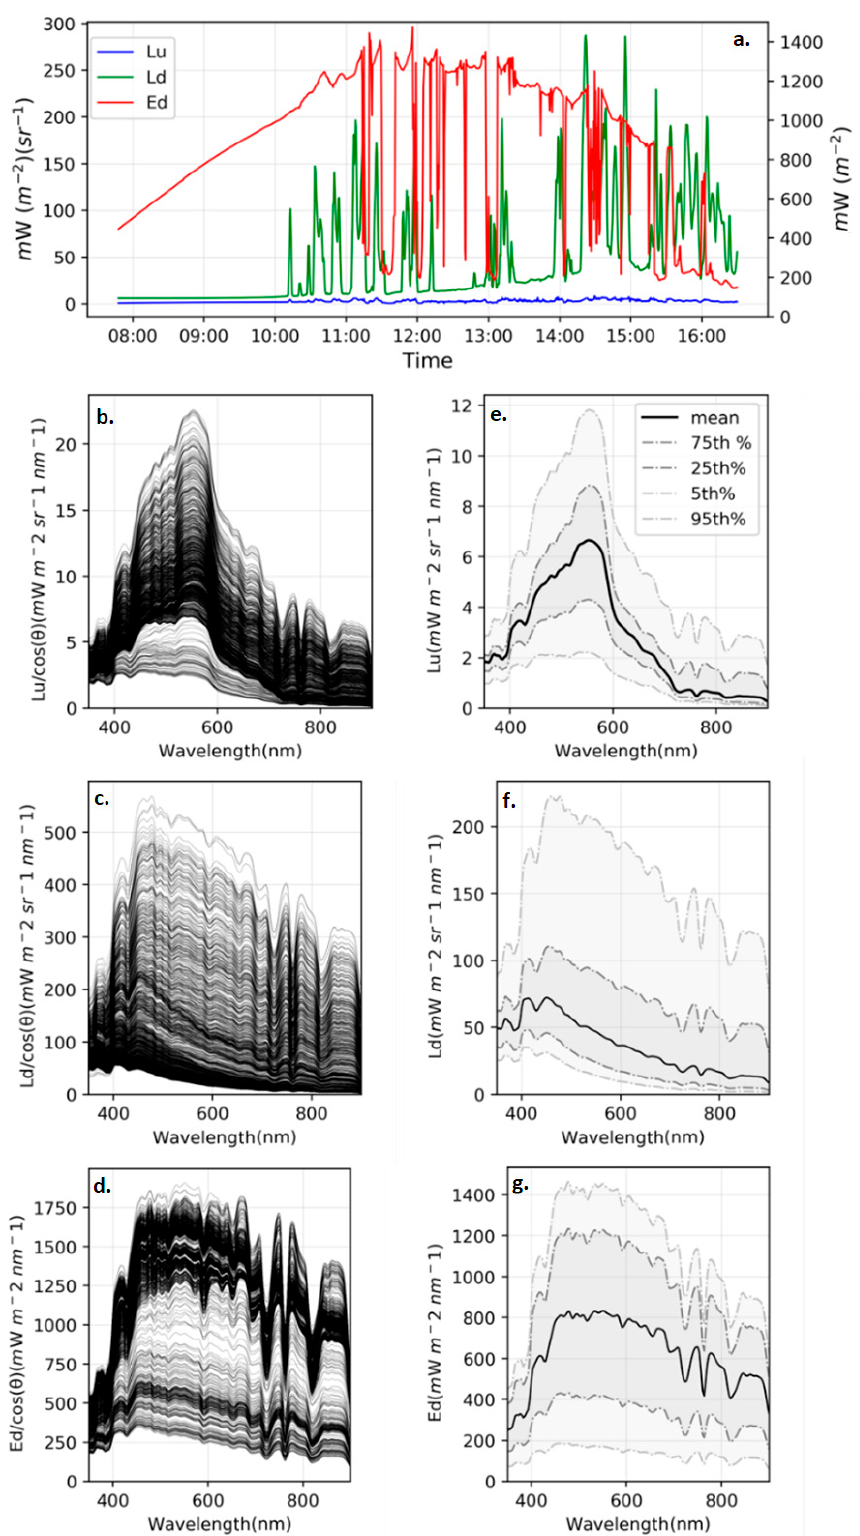
Figure 4. Radiometric measurements. Panel ( a ) shows radiometric values at 550 nm that were recorded on the 7th day of measurement, L u and L d values are shown on the main axis, and E d values are on the secondary axis. Panels ( b – d ) show cosine-normalized radiometric spectra recorded on the 7th day of measurement. Panels ( e – g ) show percentile values of radiometric spectra for the whole dataset (all 18 days).